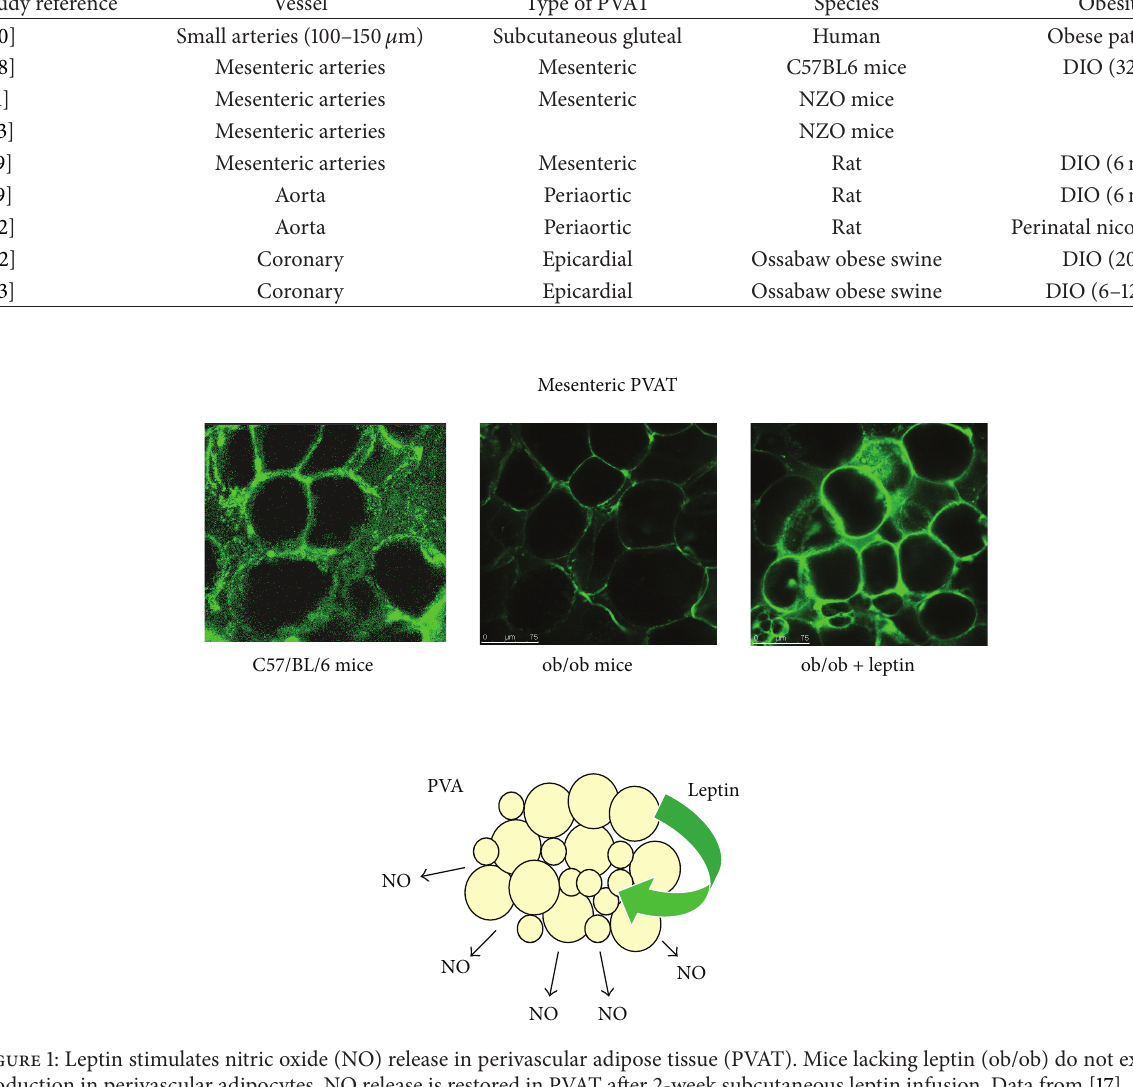
Figure 1: Leptin stimulates nitric oxide (NO) release in perivascular adipose tissue (PVAT). Mice lacking leptin (ob/ob) do not exhibit NO production in perivascular adipocytes. NO release is restored in PVAT after 2-week subcutaneous leptin infusion. Data from